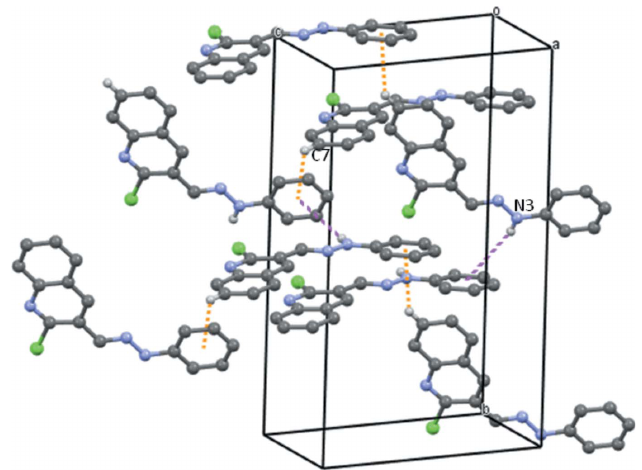
Figure 3 Chain of molecules of compound 5 linked by C—H (cid:2)(cid:2)(cid:2) (cid:2) and N—H (cid:2)(cid:2)(cid:2) (cid:2) interactions (Table 1), shown respectively, as dotted orange and purple dashed lines. For clarity, H atoms not involved in these interactions have been omitted.